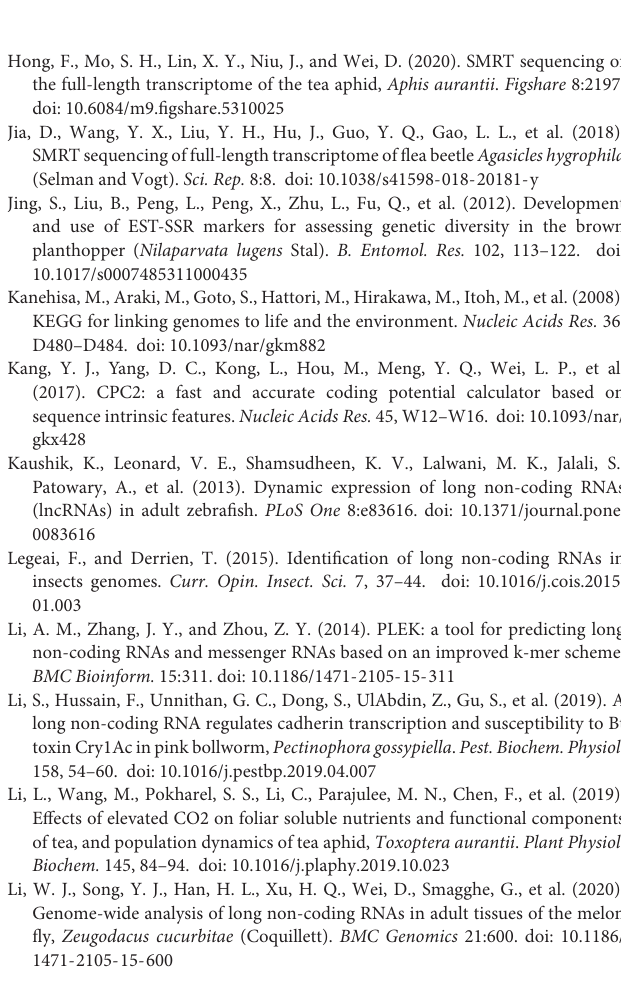
Supplementary Table 1 | Summary of reads after